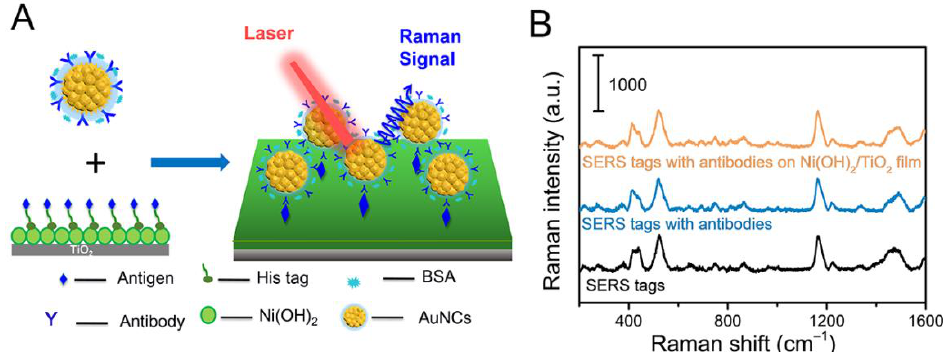
Figure 5. ( A ) Schematic diagram of SERS-based immunosensor for his-tagged antigen detection. ( B ) SERS spectra of SERS tags with different modifications.